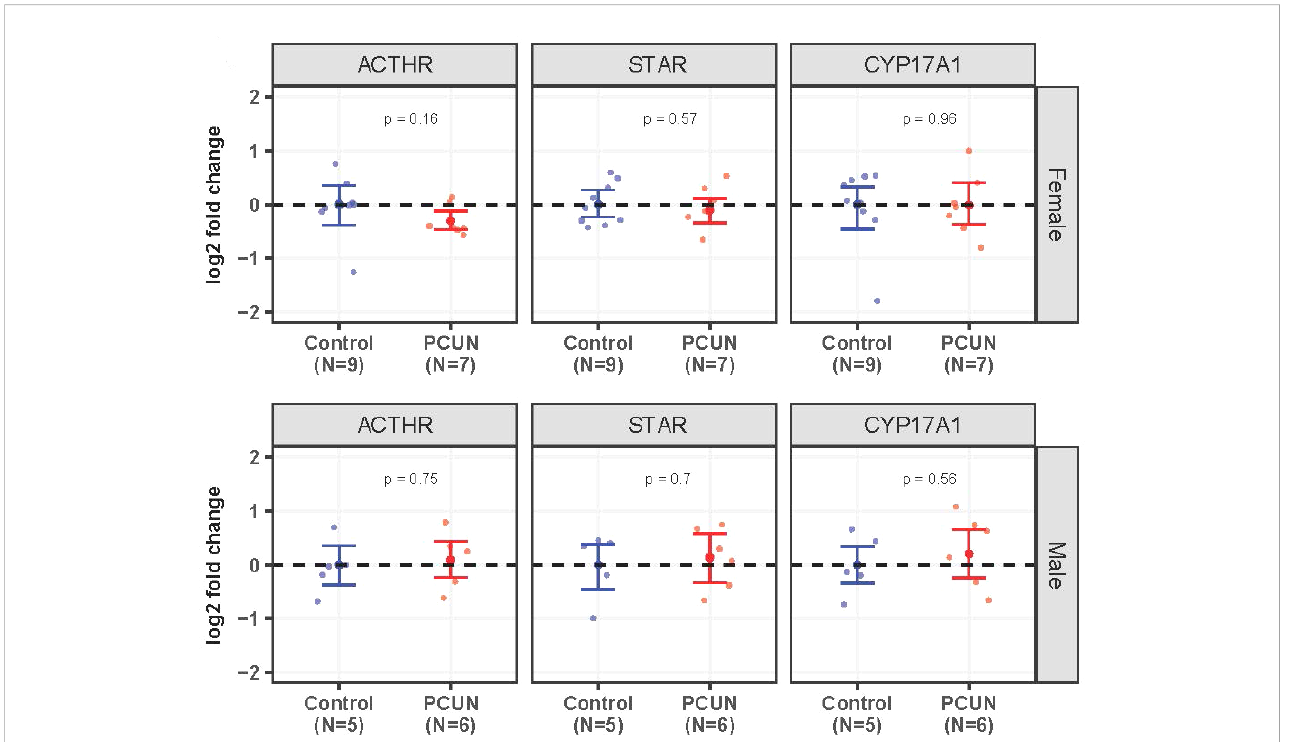
FIGURE 6 Adult adrenal mRNA expression. Log 2 fold change of ACTHR , STAR , and CYP17A1 mRNA expression levels in PCUN (symbol in red) in comparison to N (symbol in blue) in female (A) and in male (B) . Data are mean ± 95% con fi dence interval. Symbols represent individual animals. Student ’ s t-tests were used to assess statistical difference, with signi fi cance de fi ned as p <